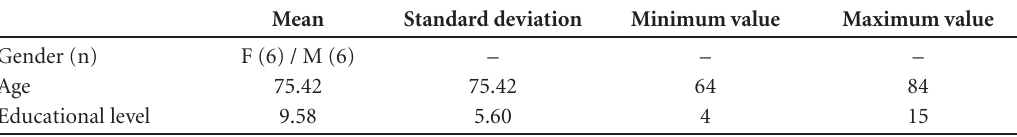
Table 1. Demographic characteristics.